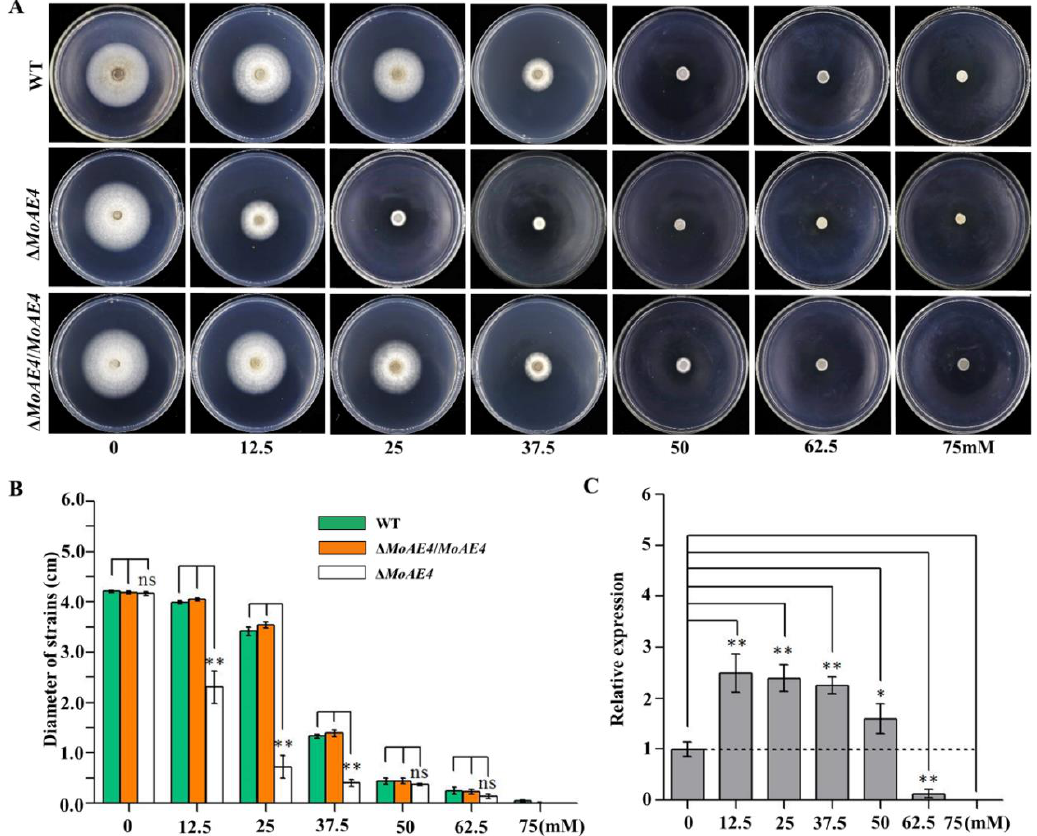
Figure 3. NaHCO 3 stress assay of the wild type and created strains and expression patterns of MoAE4. ( A ) NaHCO 3 stress assay. ∆ MoAE4 strains were more sensitive to NaHCO 3 stress than the wild-type strains. The strains were cultured in PDA media at 28 ◦ C under 0–75 mM different concentrations of NaHCO 3 and representative colonies were photographed 7 days post-inoculation. ( B ) The colonies diameter of the wild type, the ∆ MoAE4 and ∆ MoAE4 / MoAE4 mutant strains following treatments under different concentrations of NaHCO 3 . ( C ) Transcription abundance of MoAE4 under different concentrations of NaHCO 3 . Data represent the means ± standard deviation (SD) from three independent experiments in which triplicate plates were examined for each strain in each experiment. ns p > 0.05. * p < 0.05. ** p < 0.01.